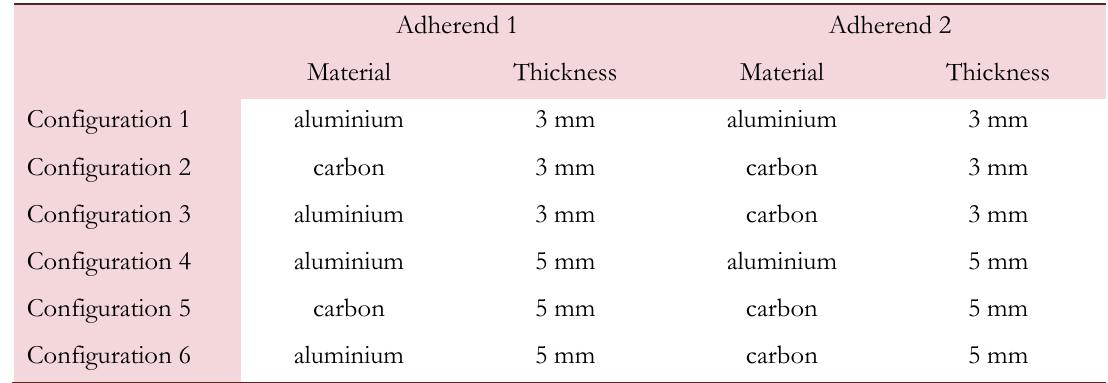
Table 2: Configurations used for testing with aluminium and carbon adherends of different